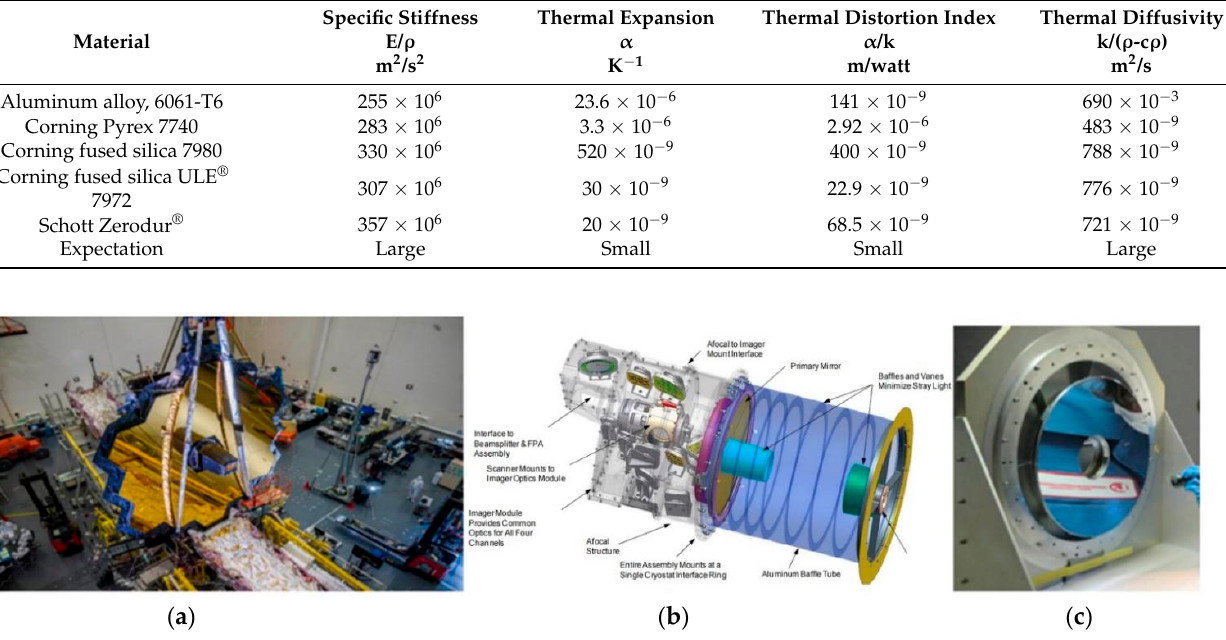
Table 1. Relative figures of merit for aluminum and glass mirror substrate materials [3].